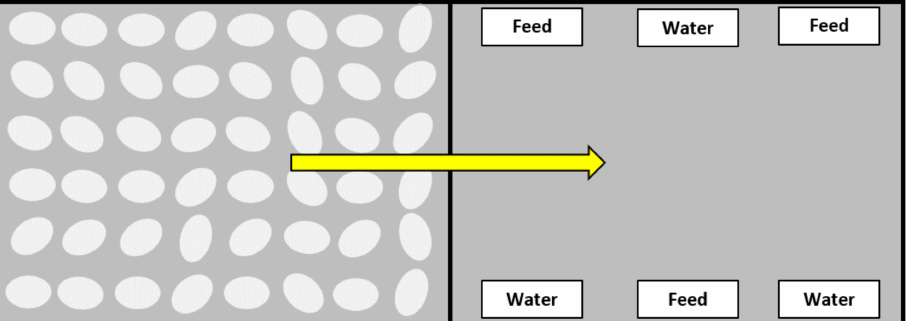
Figure 1. Layout of experimental hatching baskets. A standard hatching basket was divided down the center using mesh wire. At transfer, 84 eggs were placed in one side. At the conclusion of each hatch window period (HWP), hatched chicks were physically moved from the egg side of the basket to the treatment side that was without (control, CTL) or with feed and water (FAW). In addition to nutrient access in the hatching basket, a sub-plot treatment factor included hatch window period (HWP). A pilot trial was conducted a week in advance by hatching eggs from the same breeder flock to determine the spread of hatch and define a hatch window. Based on these data, it was determined that the hatch window be divided into four HWP based upon number of h before pull at 504 h: early (30 to 24 h), pre-peak (24 to 18 h), post-peak (18 to 12 h), and late (12 to 6 h). Each HWP represented approximately 25% of the total hatch time. At the end of each HWP, all hatched chicks were removed from the egg side of the basket, tagged for identification, and placed into the experimental side of the basket. A chick was defined as hatched once fully and independently cleared from the shell. The HWP in which a chick hatched established the amount of time chicks had access to the experimental hatching baskets (CTL or FAW). Chicks in early, pre-peak, post-peak, and late HWP had 24 h, 18 h, 12 h, of 6 h access to experimental hatching baskets, respectively. No chicks hatched more than 30 h before pull, and the relatively few chicks that hatched within 6 h of pull were not used in this experiment. Hatchability was not measured as a function of basket treatment, but overall hatchability was